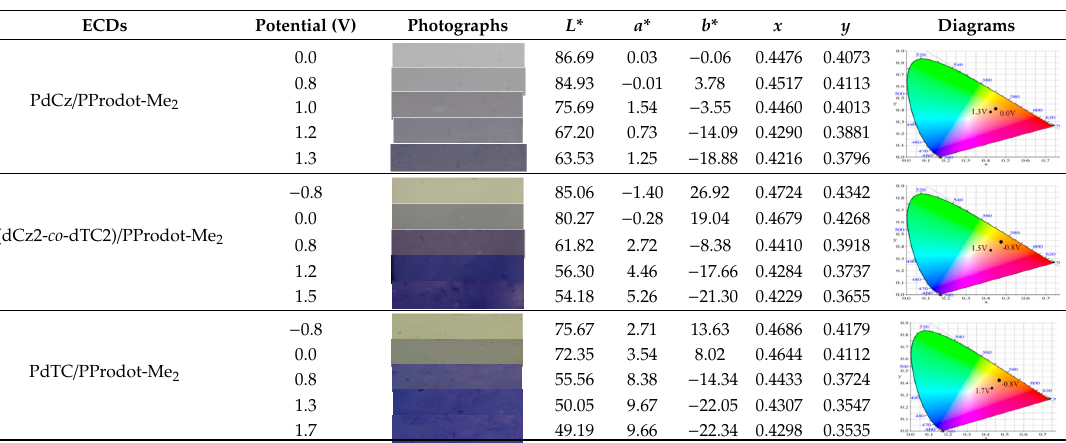
Table 4. Electrochromic photographs, colorimetric values ( L *, a *, and b *), CIE chromaticity values ( x , y ) and diagrams of the PdCz/PProdot-Me 2 , P(dCz2- co -dTC2)/PProdot-Me 2 and PdTC/PProdot-Me 2 ECDs at various applied potentials.